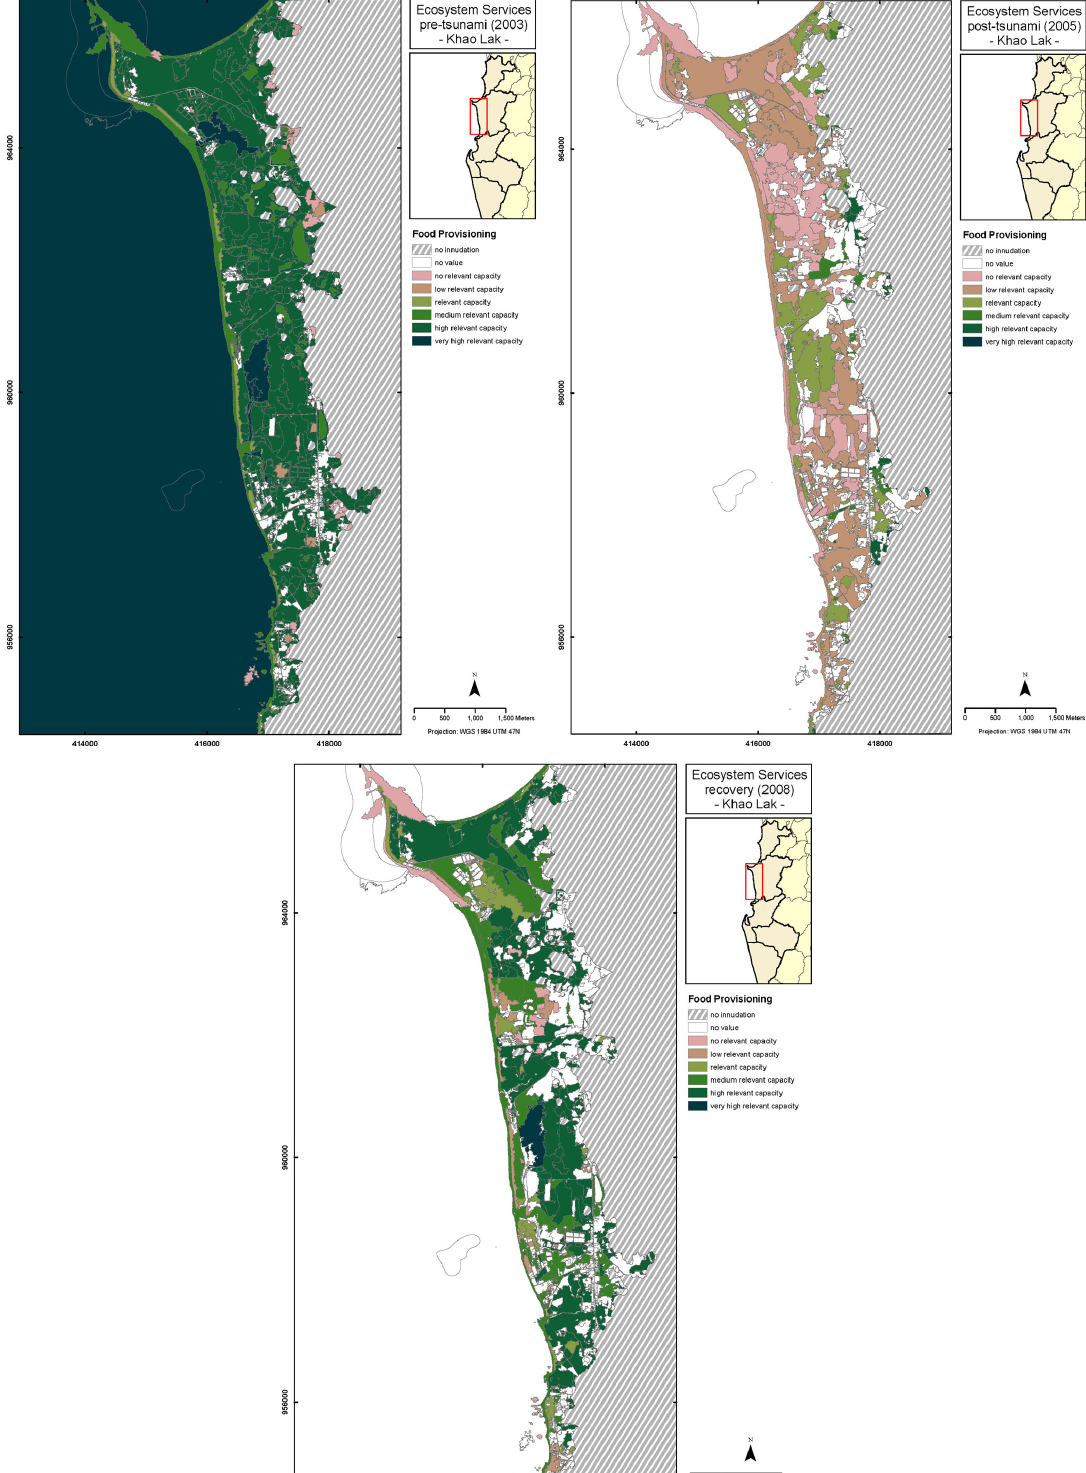
Nat. Hazards Earth Syst. Sci., 13, 3095–3111, 2013